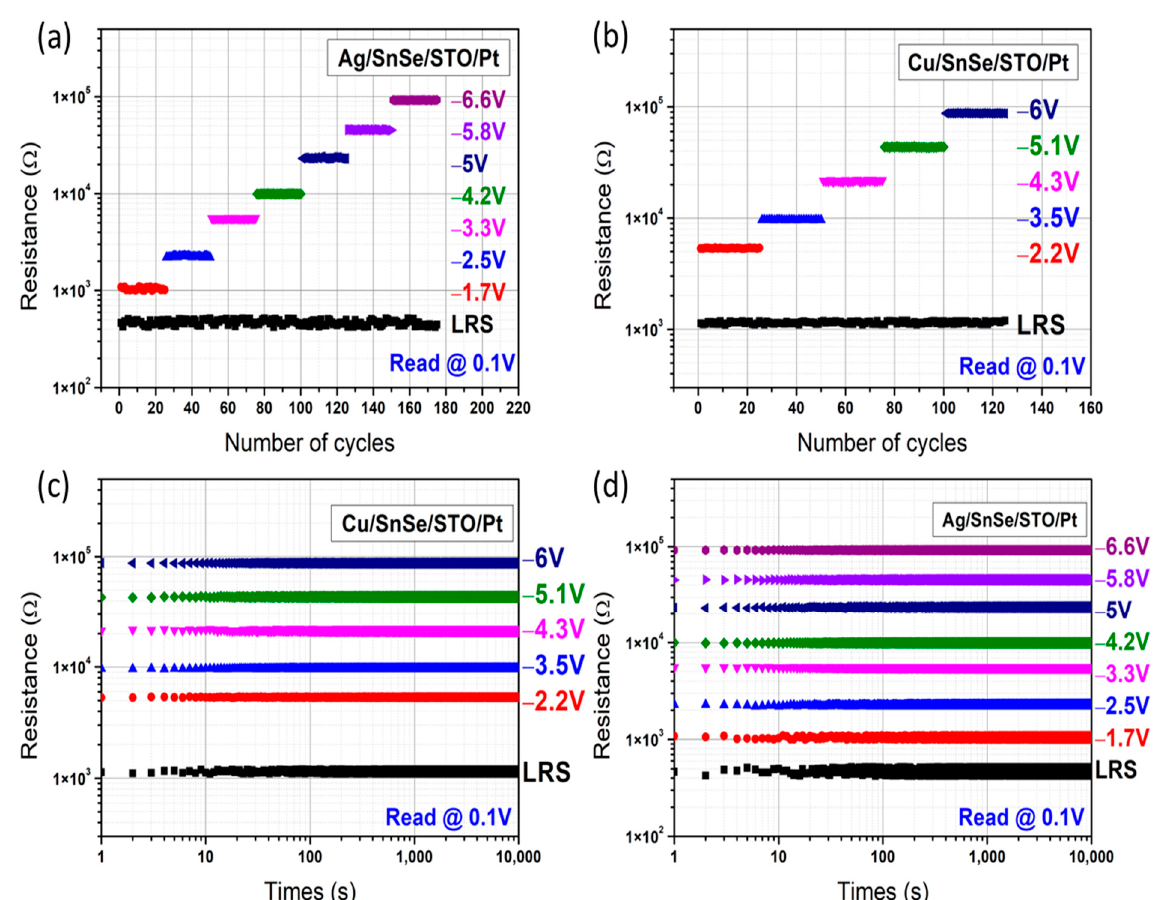
Figure 6. ( a ) The endurance characteristics of LRS and multilevel HRS under different RESET negative voltage pulses of the Cu/SnSe/STO/Pt device and ( b ) Ag/SnSe/STO/Pt device for 25 cycles each; ( c ) multilevel retention characteristics of LRS and multilevel HRS under different RESET negative voltage pulses of the Cu/SnSe/STO/Pt device and ( d ) Ag/SnSe/STO/Pt device for 10 4 s.